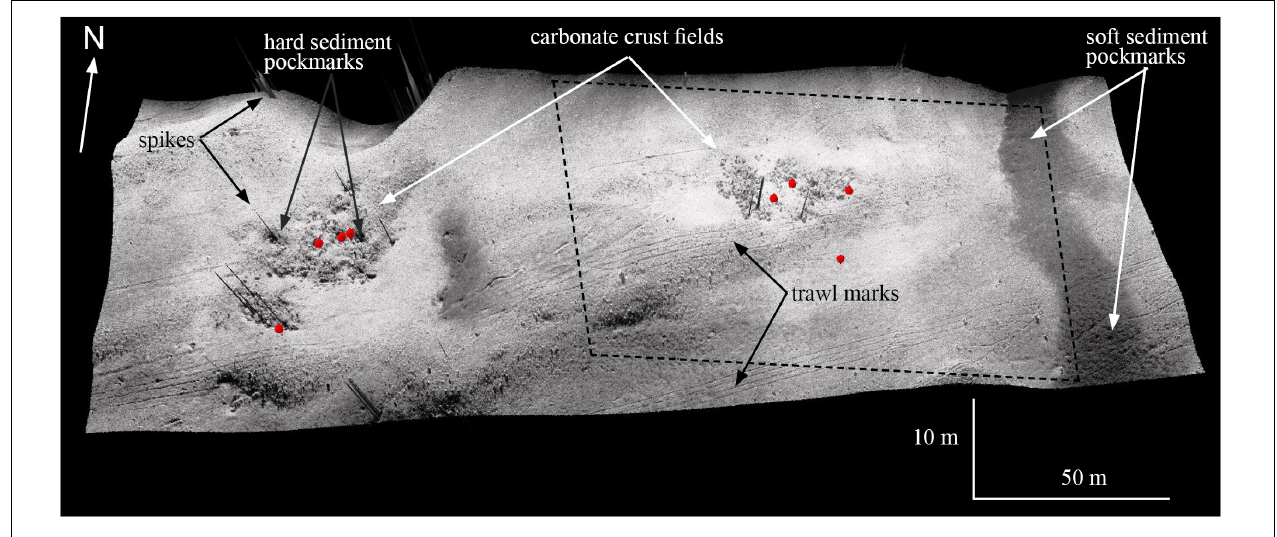
FIGURE 5 | 3D model of a subsection from Area 1, with SAS imagery (high backscatter – lighter tones, low backscatter – darker tones) draped over SAS micro-bathymetry. Carbonate crust fields, gas flares (red dots), trawl marks and pockmarks are evident. Stippled lines show the extent of Figures 4A–E . Vertical exaggeration 5 × . Water depth –233 to –227 m.